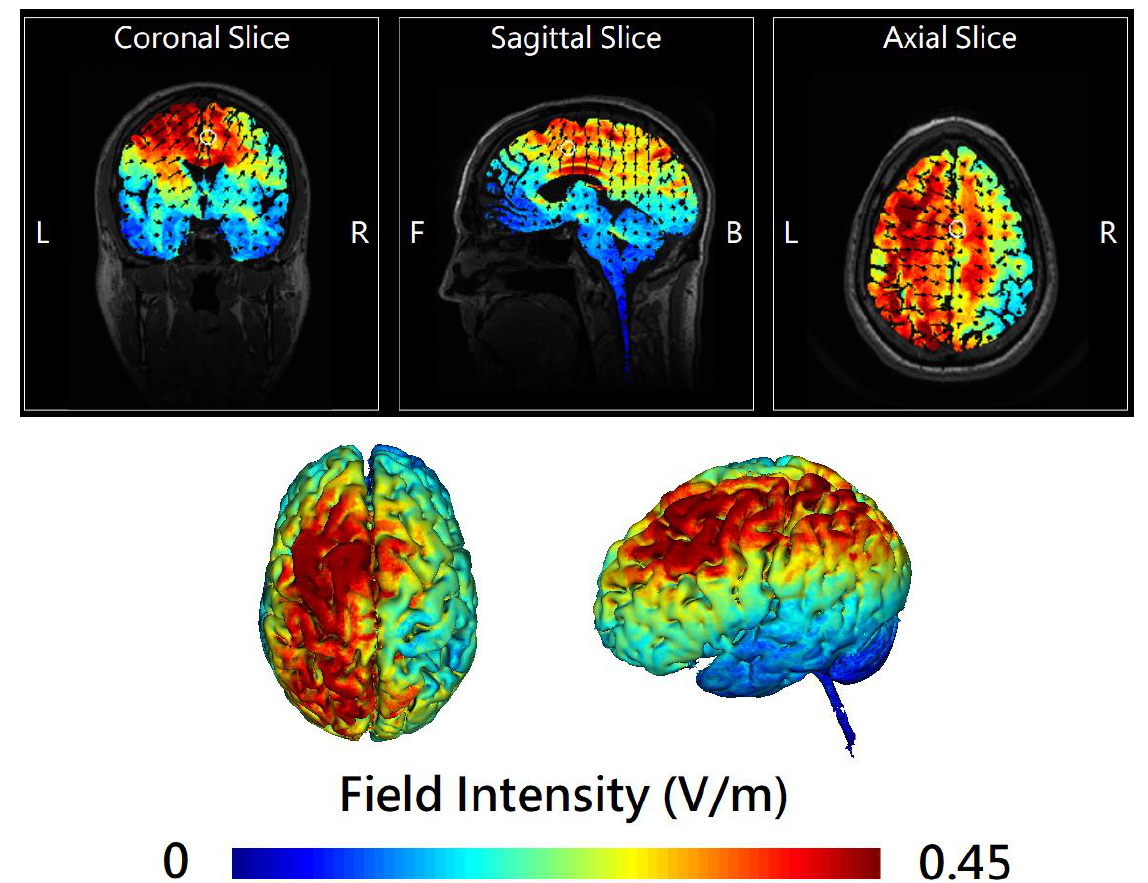
the stimulators receive.